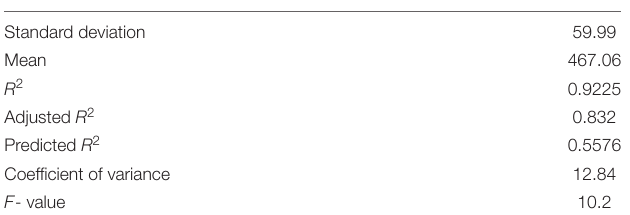
TABLE 4 | Analysis of statistical optimization via ANOVA for the